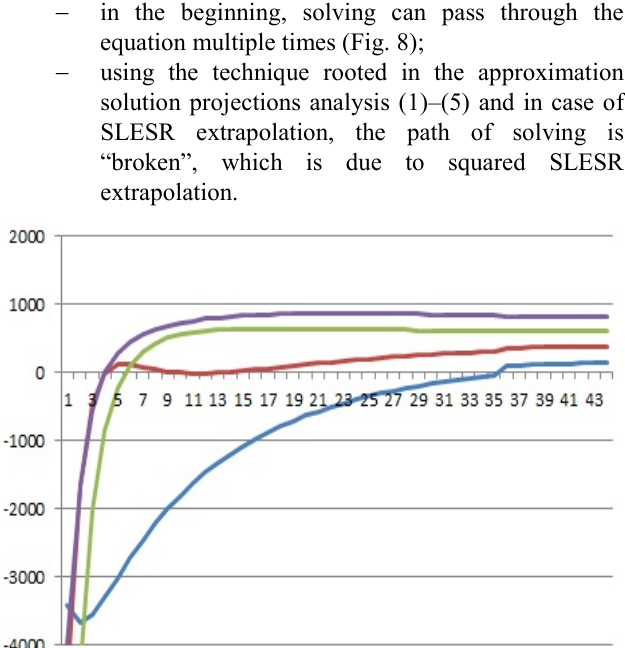
Fig. 8. Solution convergence by the technique rooted in the approximation solution projection analysis (1)–(5).